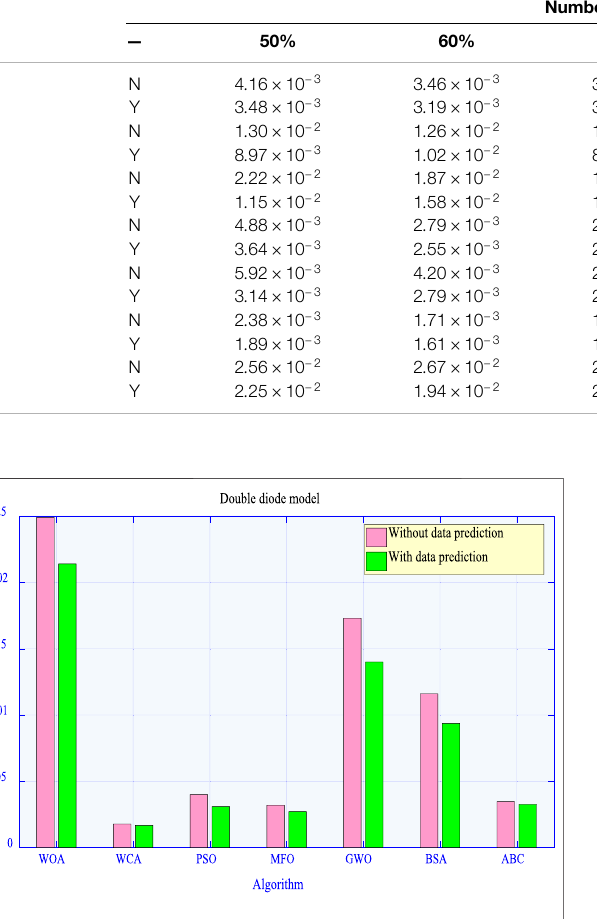
Number of measured data (%)